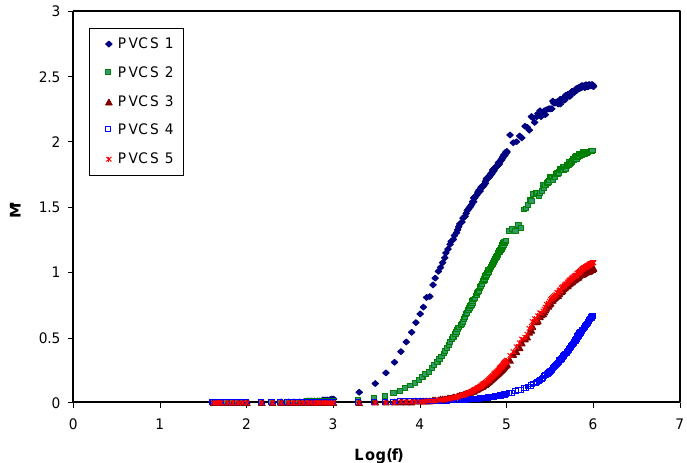
Figure 11. Real part of electric modulus versus log (f) for all polymer blend electrolytes.